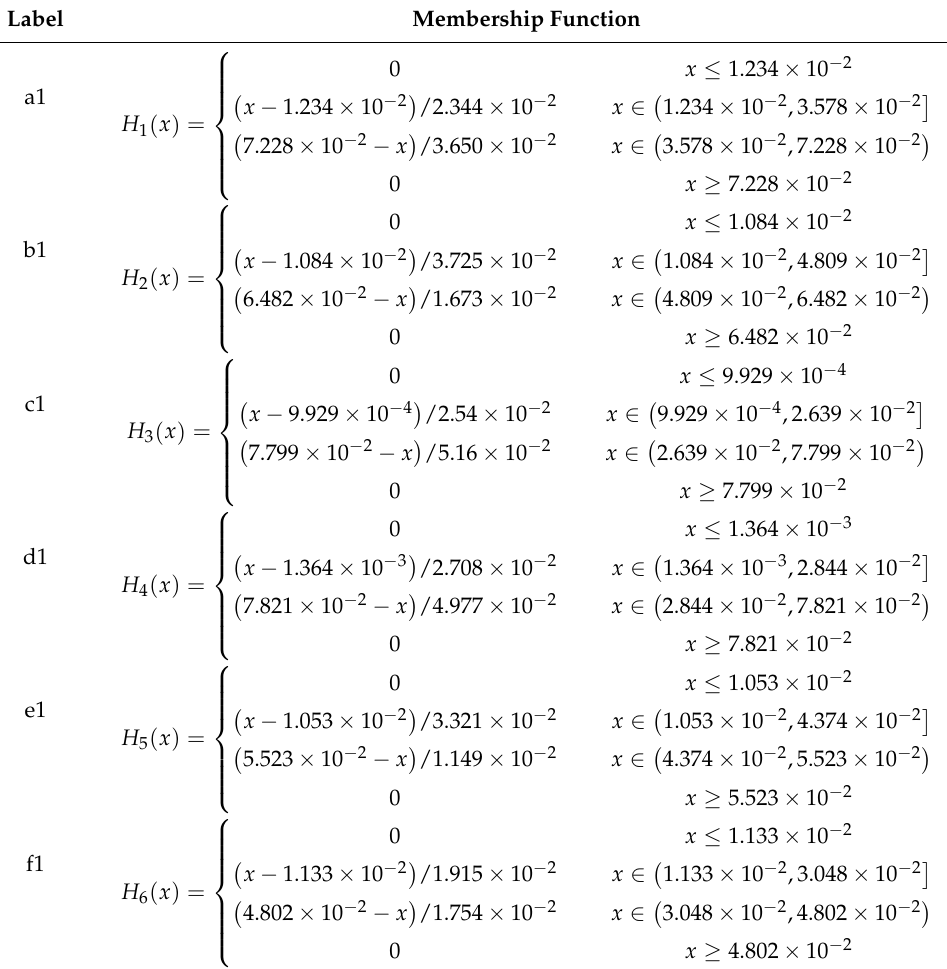
Table 9. Membership function of leakage fault in reversing